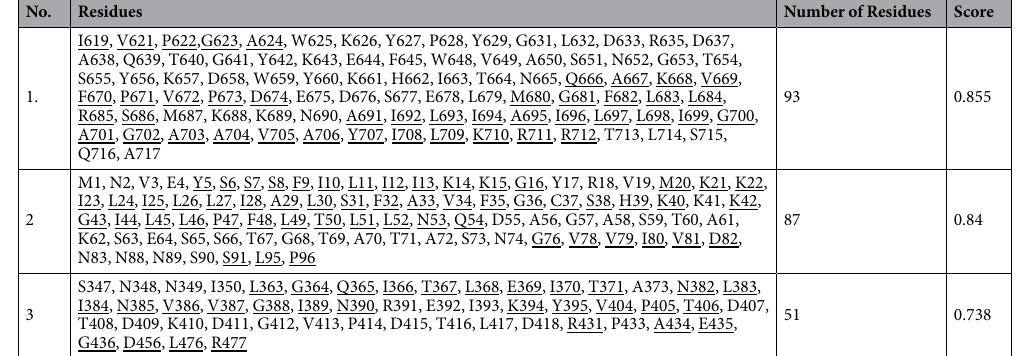
Table 5. Predicted conformational B-cell epitopes of protein. Residues (underlined) were also predicted as antigenic residue of linear B-cell epitopes.